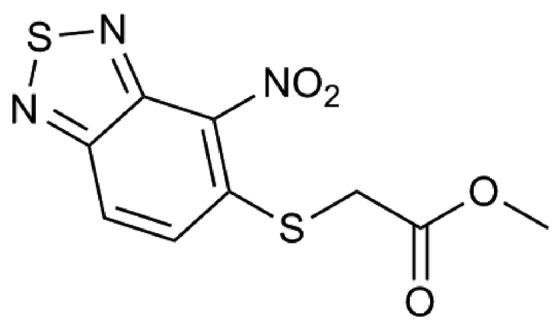
Chemical structure of 10126109 compound.